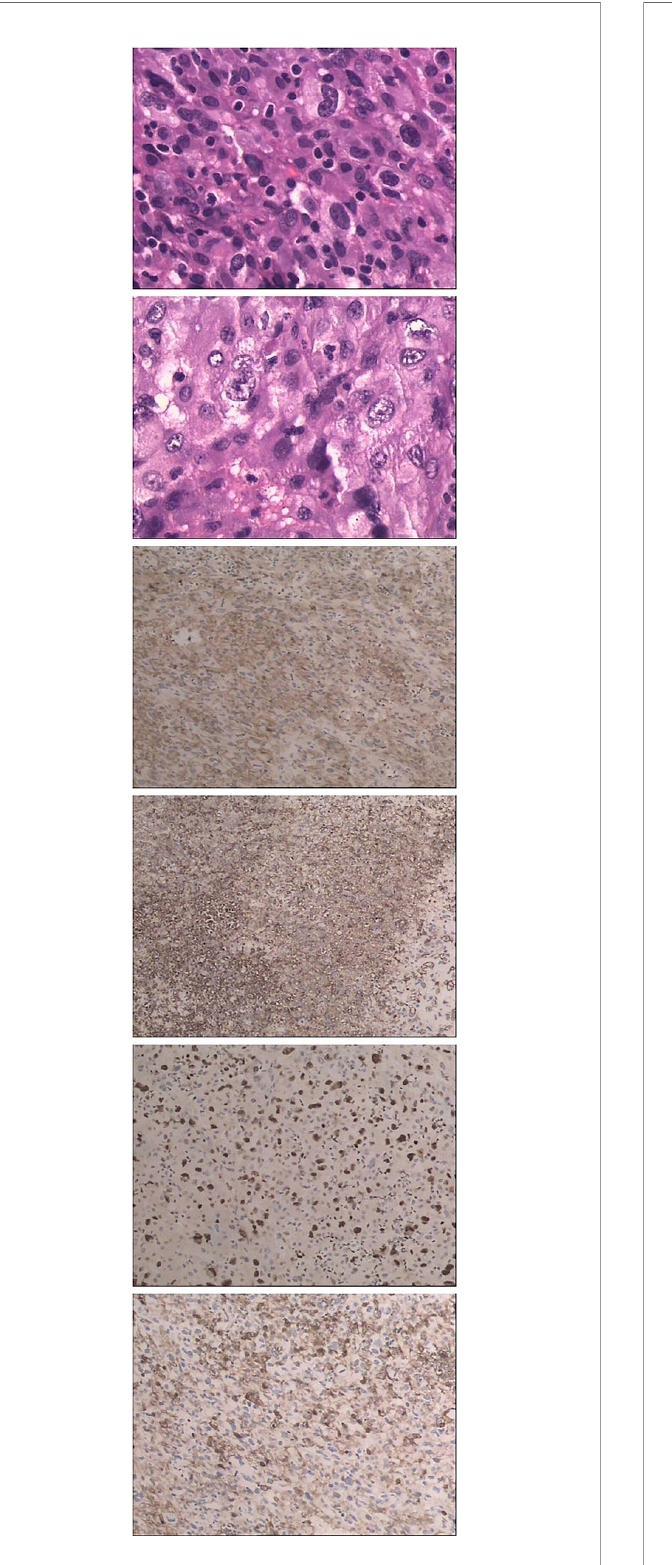
FIGURE 7 | Pulmonary CT scan showed the multi-transfer lesions of lung at the 11th month of